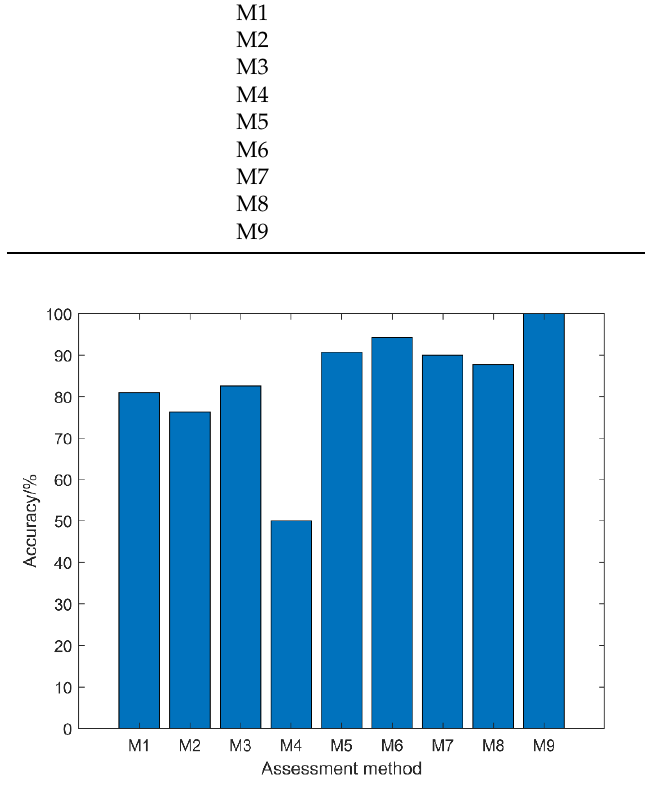
Figure 15. Graph of the evaluation results under different assessment methods.